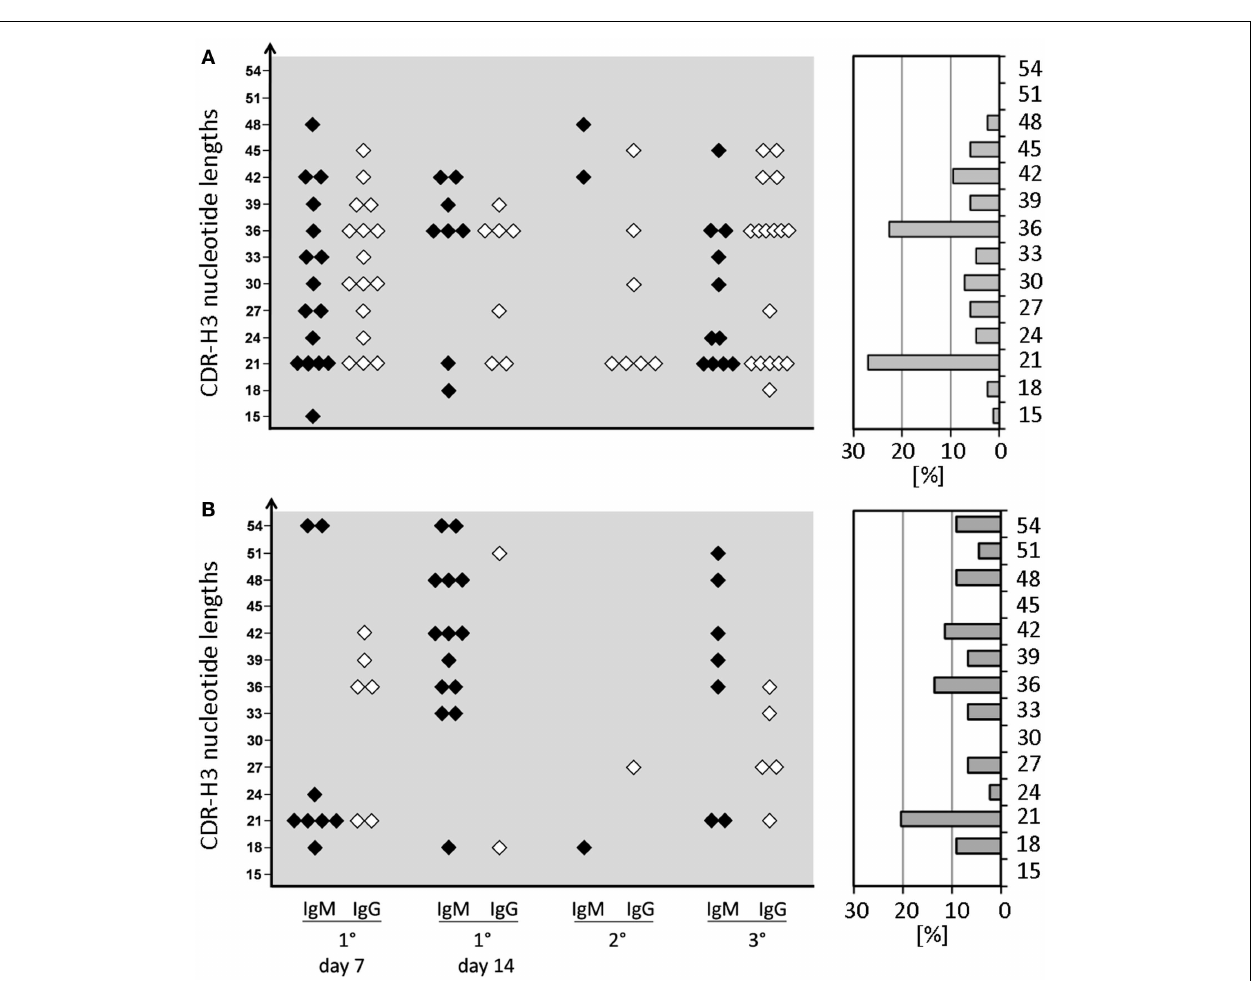
Material.The CDR-H3 nucleotide lengths of IgM (black symbols) and IgG (white symbols) monoclonal anti-phOx Ab from different stages of the immune response of ∆ D-D µ FS mice are shown in (A) and those of ∆ D-iD mice in (B) .The percental contribution of each nucleotide length is indicated by gray bars at the right hand